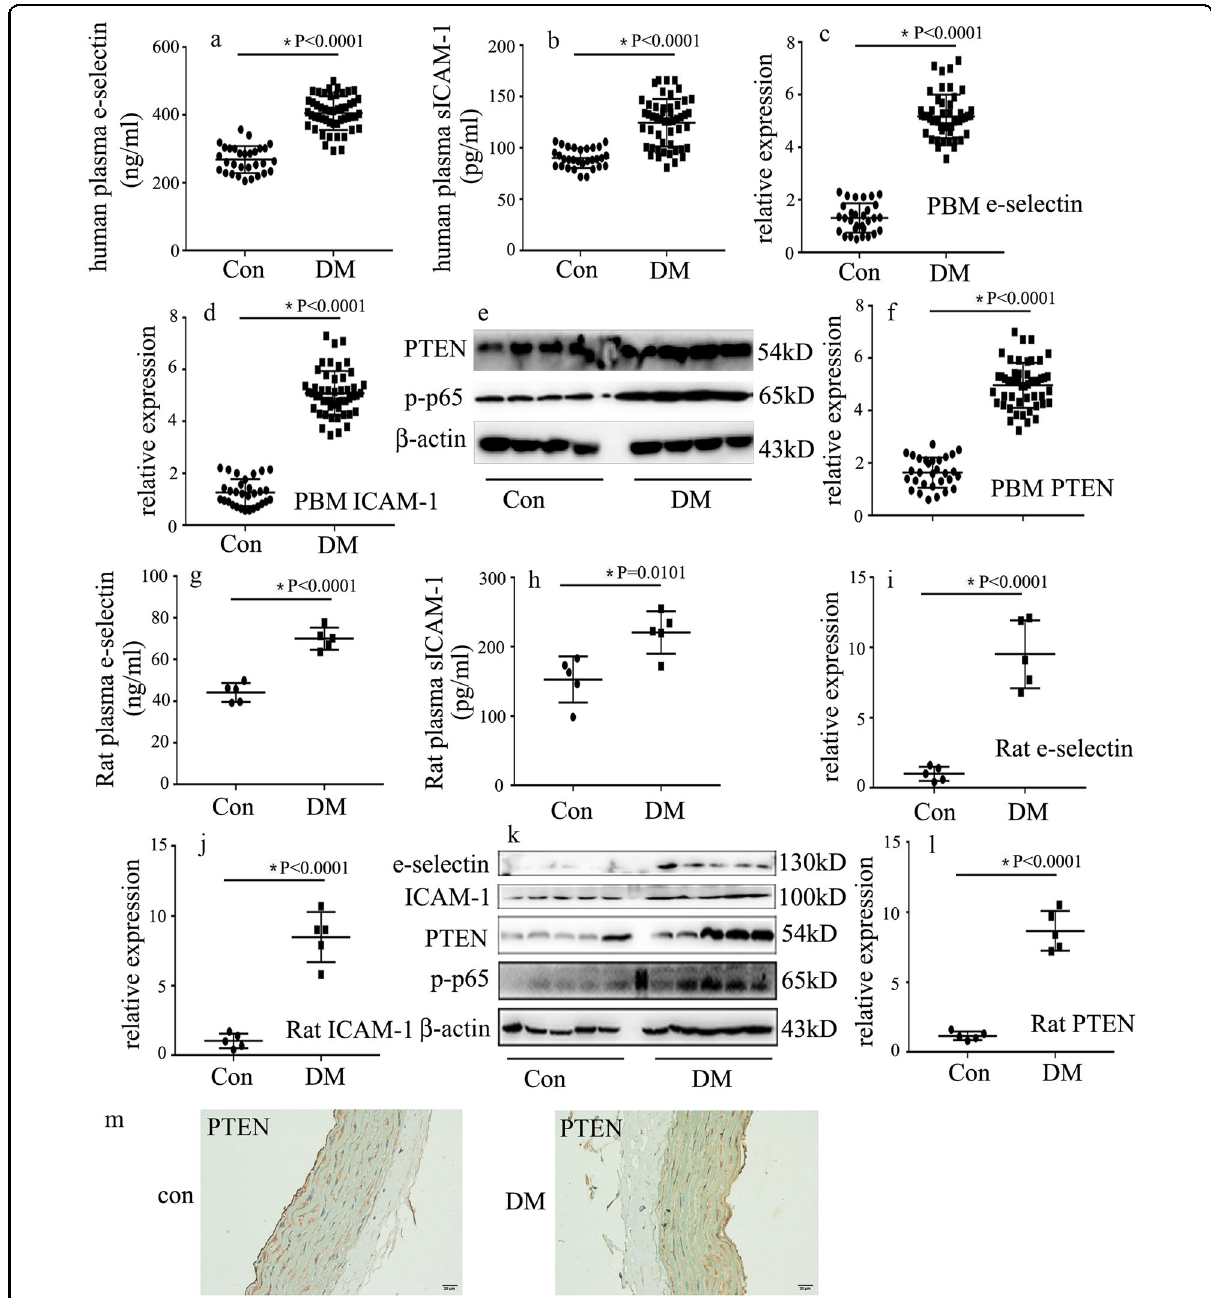
Fig. 1 e-selectin, sICAM-1, and PTEN expression levels were increased in patients with diabetes and rats. a Plasma e-selectin was measured in patients with diabetes and healthy volunteers (con: n = 30, DM: n = 50). b Plasma sICAM-1 was measured in patients with diabetes and healthy volunteers (con: n = 30, DM: n = 50). c The mRNA expression of e-selectin was examined by qPCR in peripheral blood mononuclear cells in the subjects (con: n = 30, DM: n = 50). d The mRNA expression of sICAM-1 was examined by qPCR in peripheral blood mononuclear cells in the subjects (con: n = 30, DM: n = 50). e Results from the western blot analysis of PTEN and p-p65 expressions in peripheral blood mononuclear cells in the subjects (con: n = 30, DM: n = 50). f The mRNA expression of PTEN was examined by qPCR in peripheral blood mononuclear cells in the subjects (con: n = 30, DM: n = 50). g Plasma e-selectin was measured in the control group and diabetic group rats ( n = 5/group). h Plasma sICAM-1 was measured in the control group and diabetic group rats ( n = 5/group). i The mRNA expression of e-selectin was examined by qPCR in rat aortic tissues in the control group and the diabetic group ( n = 5/group). j The mRNA expression of ICAM-1 was examined by qPCR in rat aortic tissues from the control group and the diabetic group ( n = 5/group). k Results from the western blot analysis of e-selectin, ICAM-1, PTEN, and p-p65 expression in rat aortic tissues from the control group and the diabetic group ( n = 5/group). l The mRNA expression of PTEN was examined by qPCR in rat aortic tissues from the control group and the diabetic group ( n = 5/group). m Immunostaining of PTEN in rat aortic tissues from the control group and the diabetic group ( n = 5/group). Scale bar, 20 μ m. PBM peripheral blood mononuclear cells. * P < 0.05, compared with the control